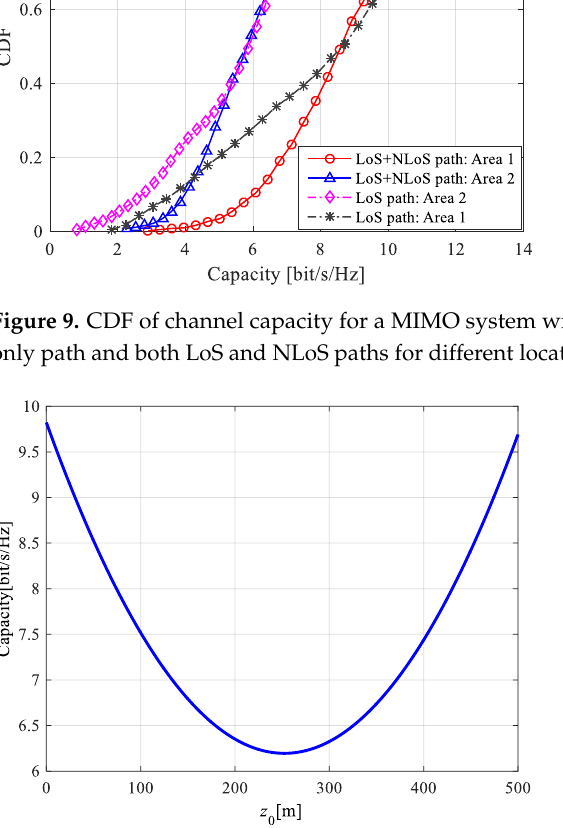
Figure 10. Channel capacity of the LCX-MIMO system with a different location in the tunnel.